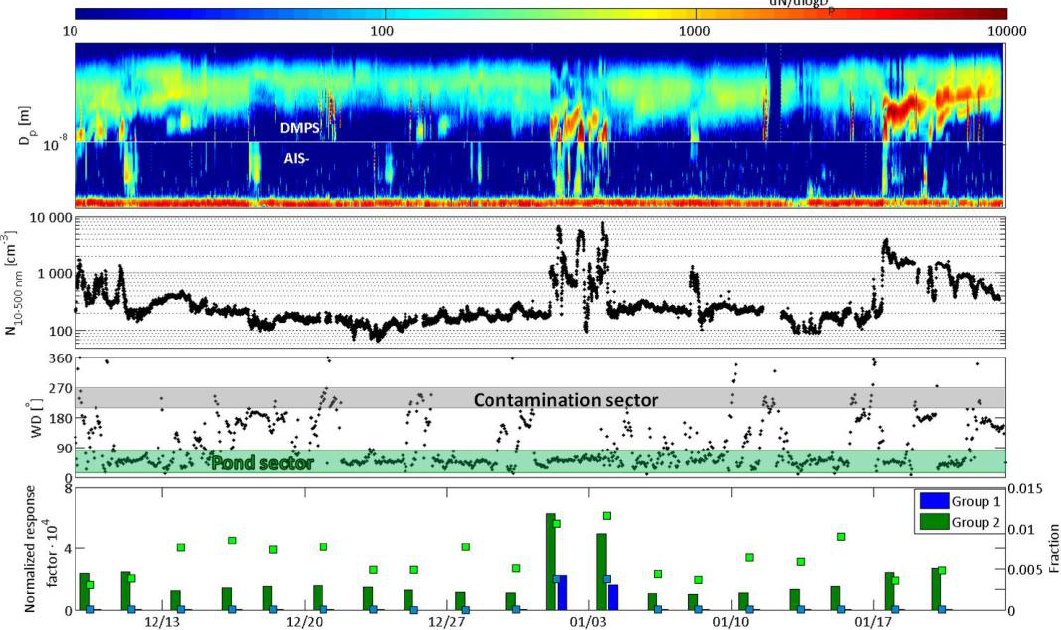
Fig. 2. The negatively charged (0.8–10nm) and neutral particle (10–500nm) number size distribution (upper panel) during the campaign, 8 December 2009 to 23 January 2010 (the time axis is the same in every figure). The total particle concentration, where the contamination has been taken away, is given in the second panel. The third panel shows the wind direction at 1h time resolution with the pond and contamination Figure 2 The negatively charged (0.8 – 10 nm) and neutral particle (10 – 500 nm) number 6 sectors shaded with green and grey, respectively. The lowermost panel shows the normalized response factor (bars) of Group 1 and Group 2 compounds as well as their fraction from all detected organic compounds (coloured size distribution (upper panel) during the campaign, 5 December 2009 to 23 January 2010 7